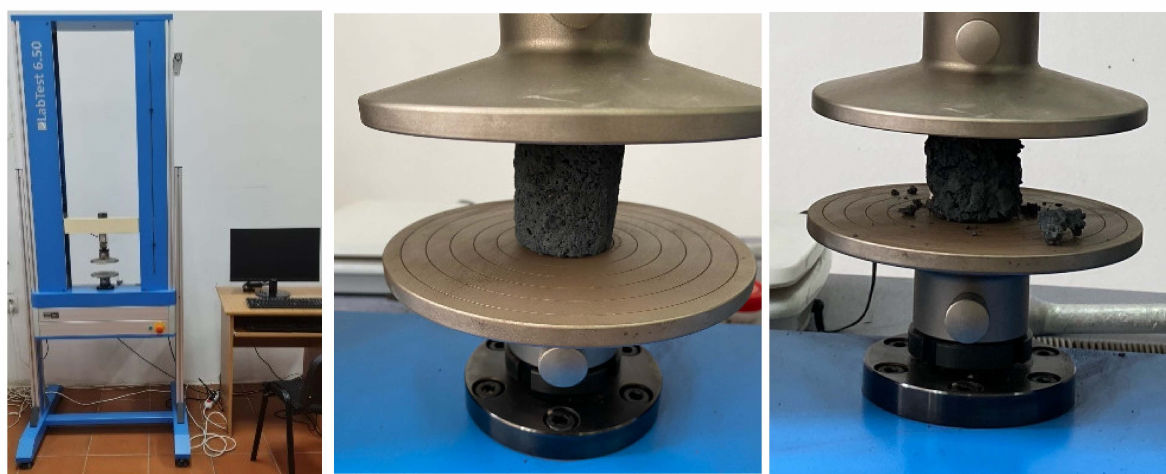
Figure 12. Determination of the briquette’s resistance